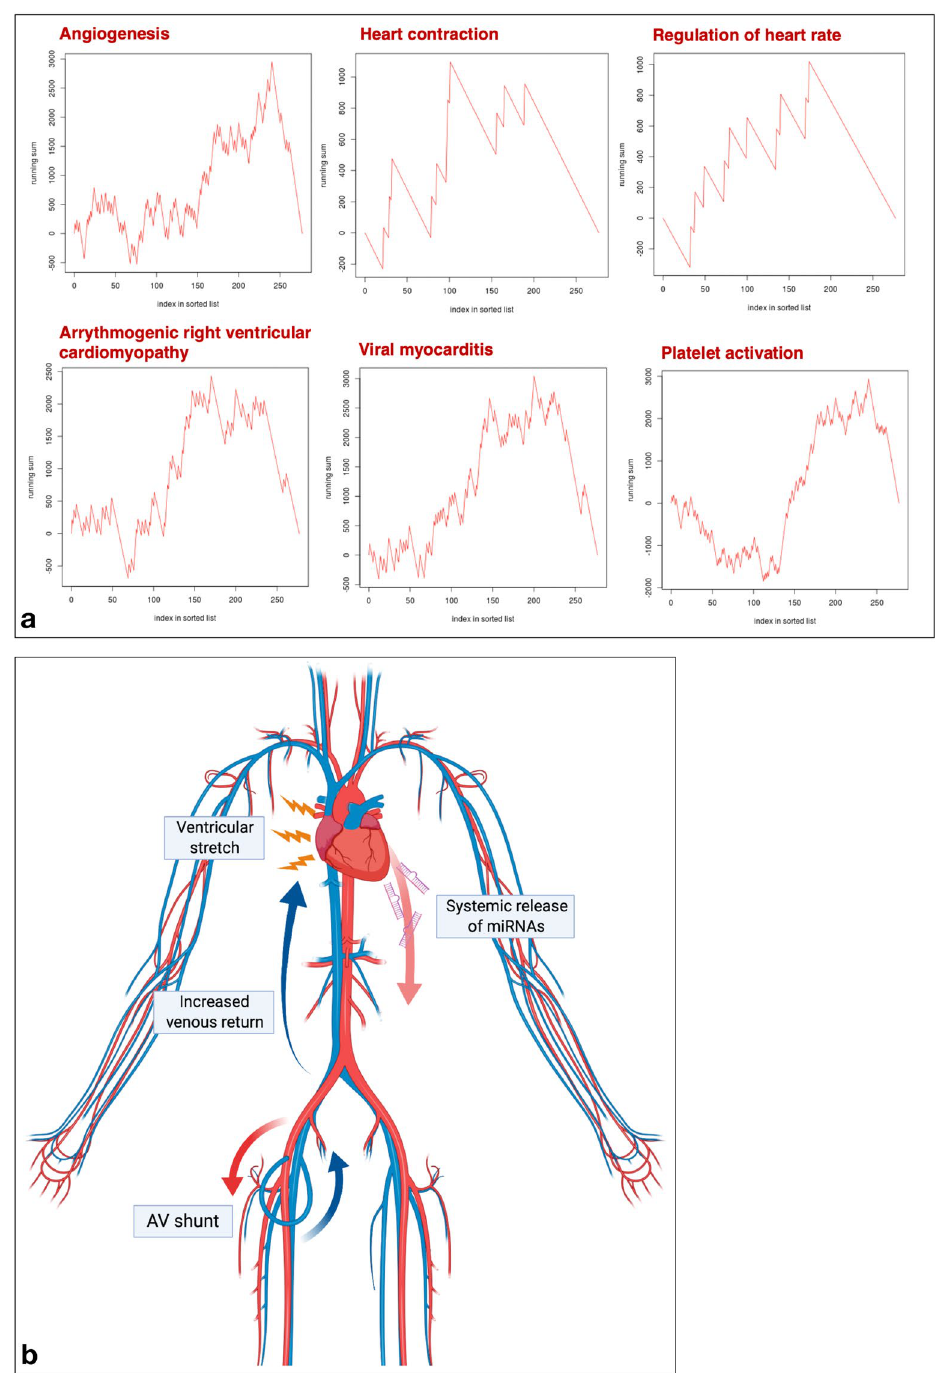
Figure 4. (a) Selection of gene sets with predicted enrichment in response to the deregulated miRNAs in the peripheral blood after arteriovenous (AV) loop placement by miRNA Enrichment and Annotation Analysis. ( b ) Pathophysiologic mechanism behind systemic miRNA release into the circulation. AV loops cause an increase in venous return to the heart, leading to cardiac volume loading and ventricular stretch, which is a stimulus for the release of natriuretic peptides and likely also miRNAs into the circulation. Figure schematic created with